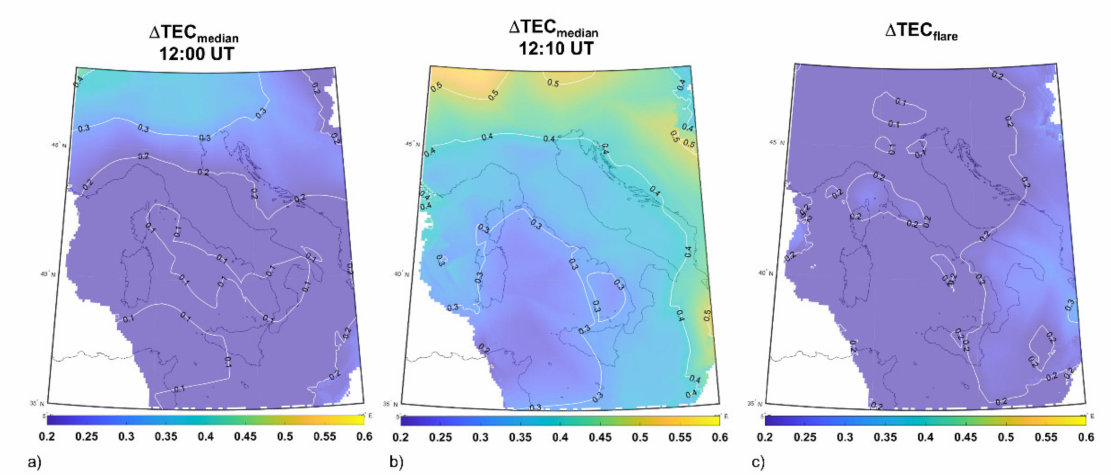
Figure 11. Maps of percentage difference between median vTEC considering 27-days before the X9.3 flare on 6 September 2017 and vTEC maps ( ∆ TEC median ) at 12:00 UT (panel a ), i.e., before the flare, and 12:10 UT (panel b ), i.e., after the flare, and the difference between the two ( ∆ TEC flare , panel c